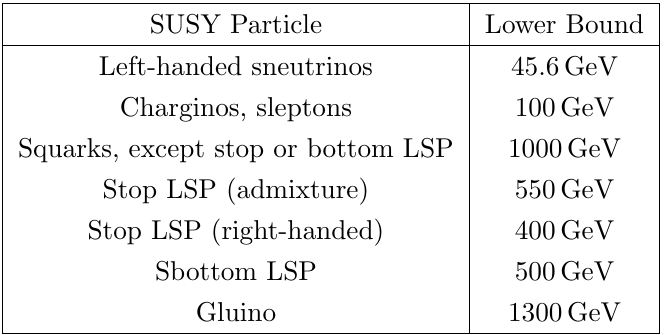
Table 1. Current lower bounds on the SUSY particle